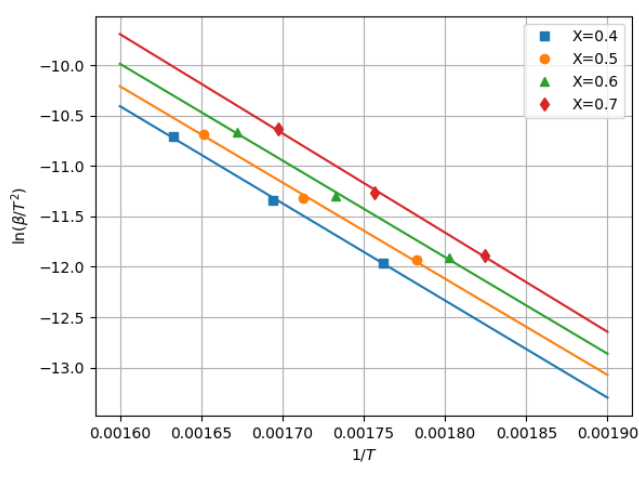
Figure 8. Sets of data ( 1/ T , ln ( β / T 2 )) at a fixed X and fitting curves.